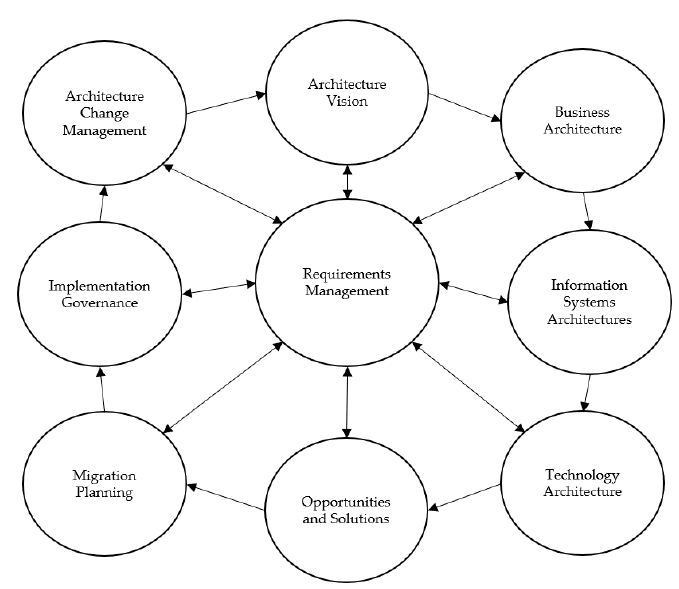
Figure 2. TOGAF framework implemented in Org 1, adapted from [29] .